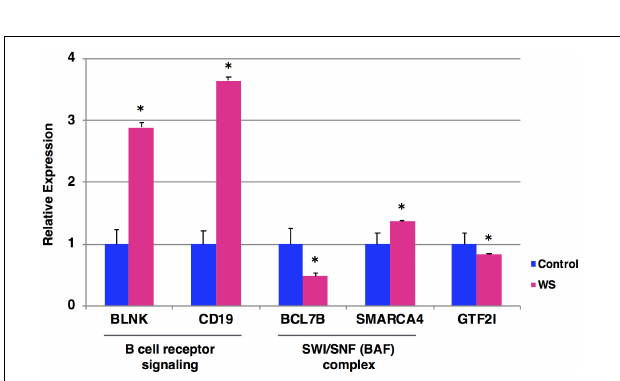
FIGURE 3 | Expression levels of the selected five genes by qRT-PCR. The relative expression level of each gene was normalized to that of the internal control GAPDH from a WBS patient at the age of 19 years who have not yet developed Burkitt lymphoma (red) and five age/sex-matched control subjects (blue). Student’s t -test was used for the statistical analysis. ∗ P -values < 0.05 were considered statistically